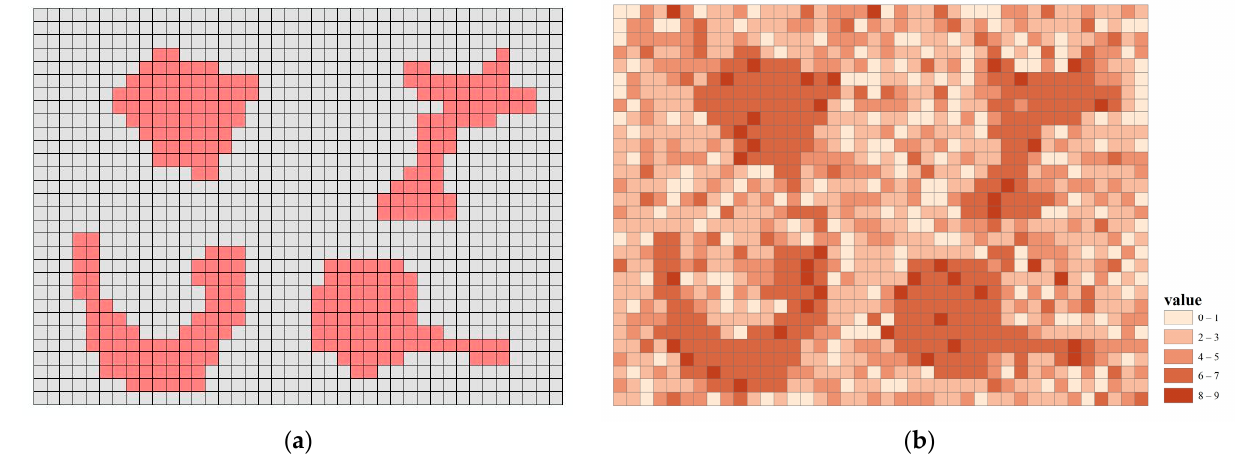
Figure 2. Designed hotspot area ( a ) and the final simulation data ( b ).